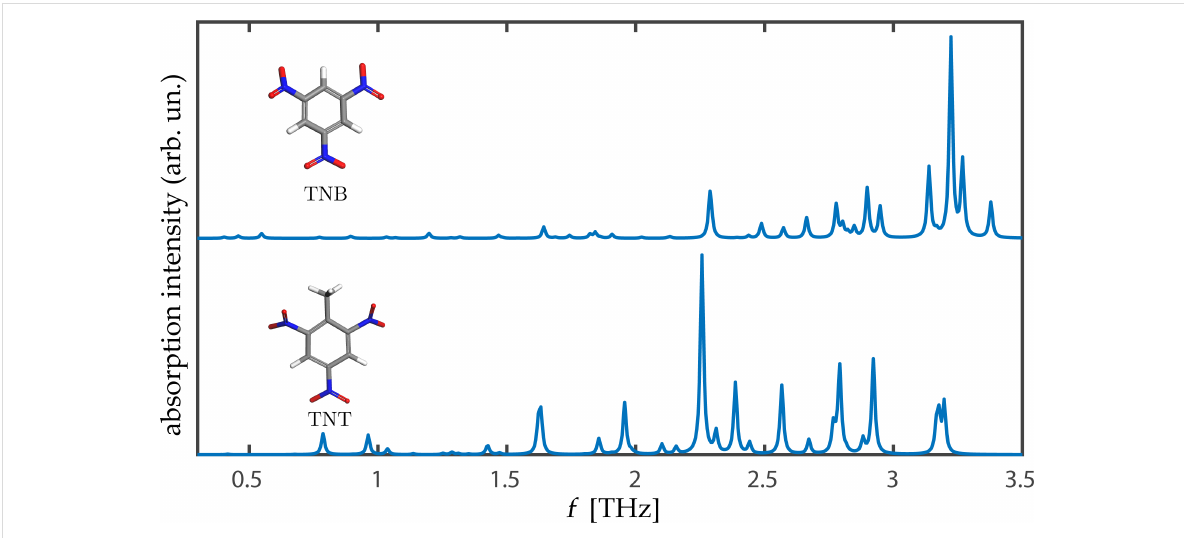
Figure 6: Comparison of computed terahertz spectra, as computed with the PBE+TS-vdW approximation, for the orthorhombic TNB and TNT crys- tals. Schematic views of the TNT and TNB molecules are given as